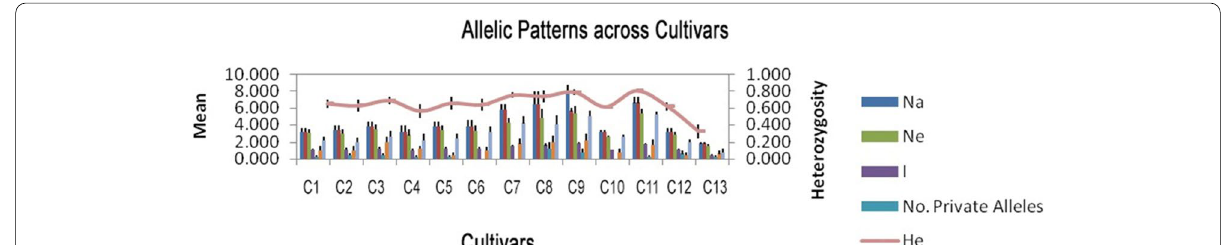
Fig. 1 Band pattern of studied cultivars and genetic parameters obtained for each cultivar. Cultivar number according to Table 1. Na, no. of different alleles; Ne, no. of effective alleles